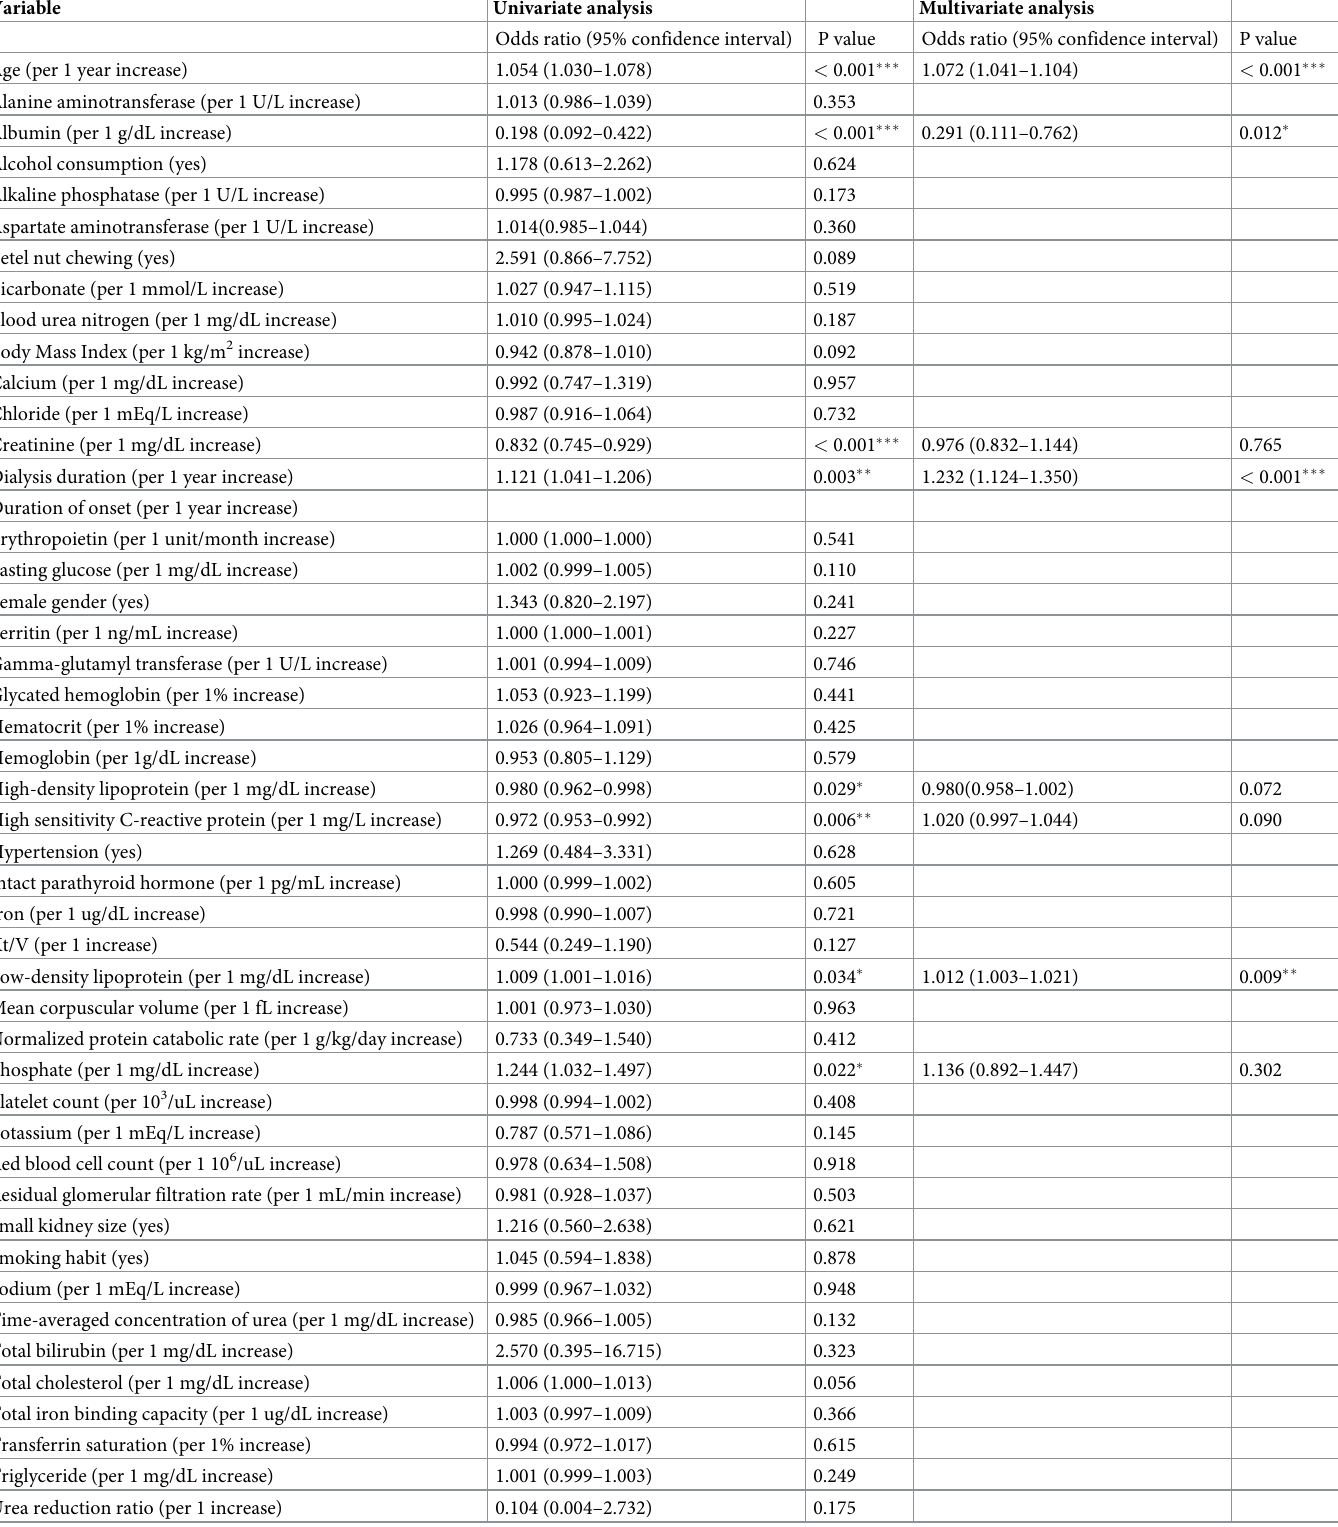
Table 5. Analysis of mortality using a logistic regression model (n =